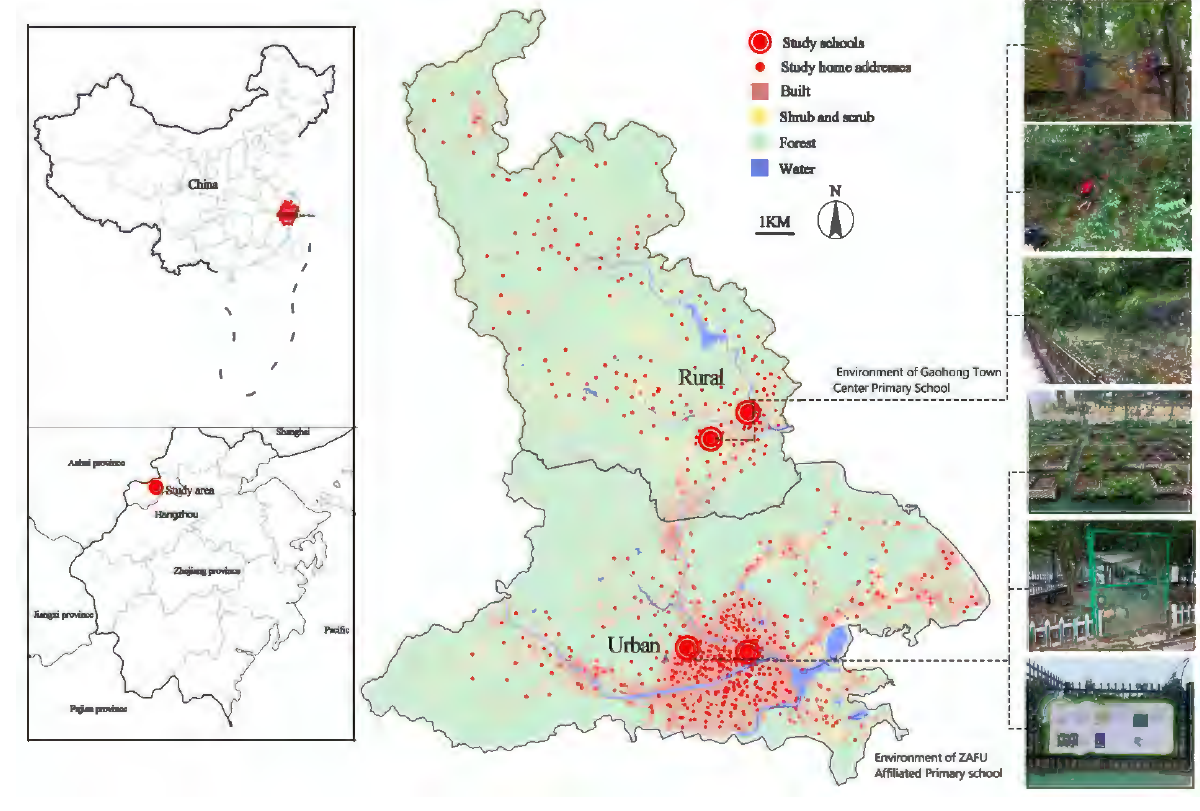
Figure 1. Research area